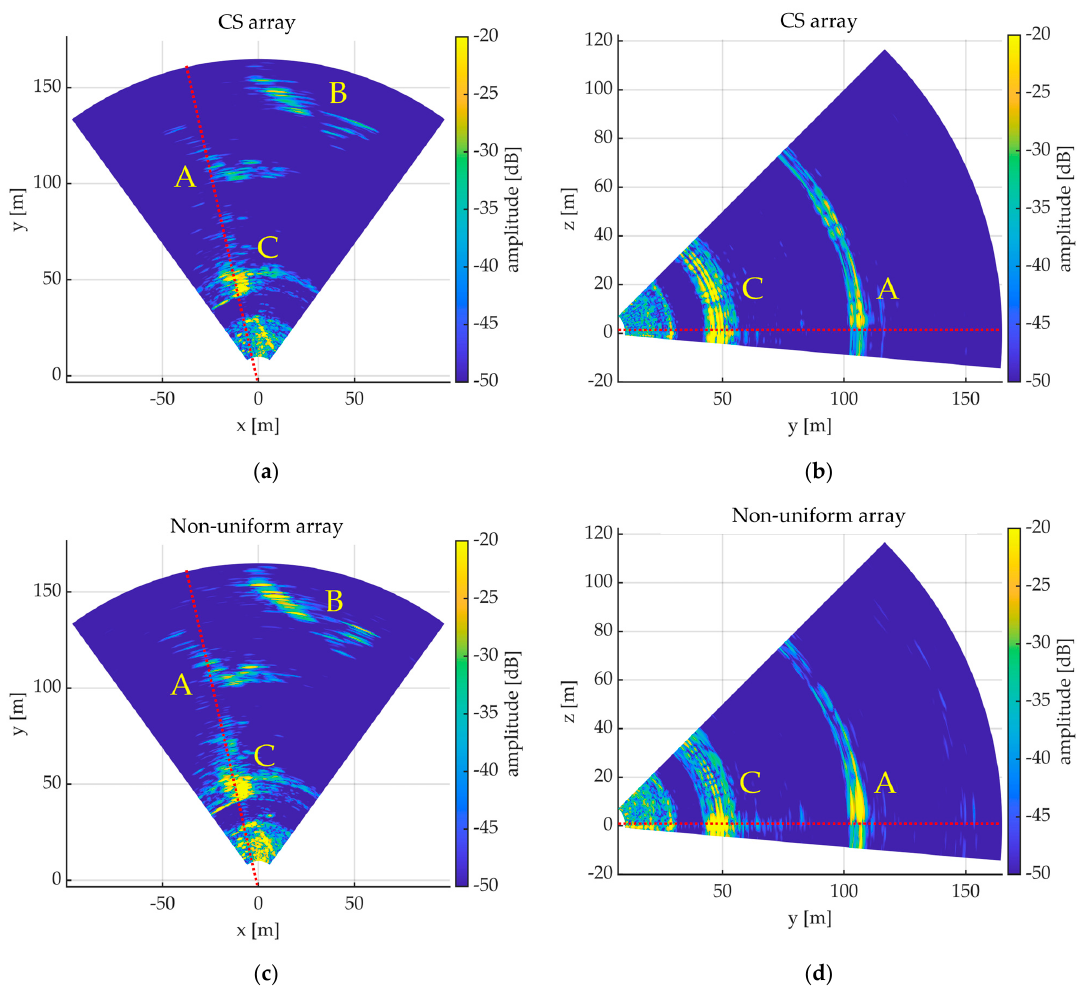
Figure 11. Radar images focused: on the x-y plane obtained with the CS array ( a ) and with the non- uniform array ( c ); on the y–z plane obtained with the CS array ( b ) and with the non-uniform array ( d ). Dotted line is the intersection between the two orthogonal image planes.